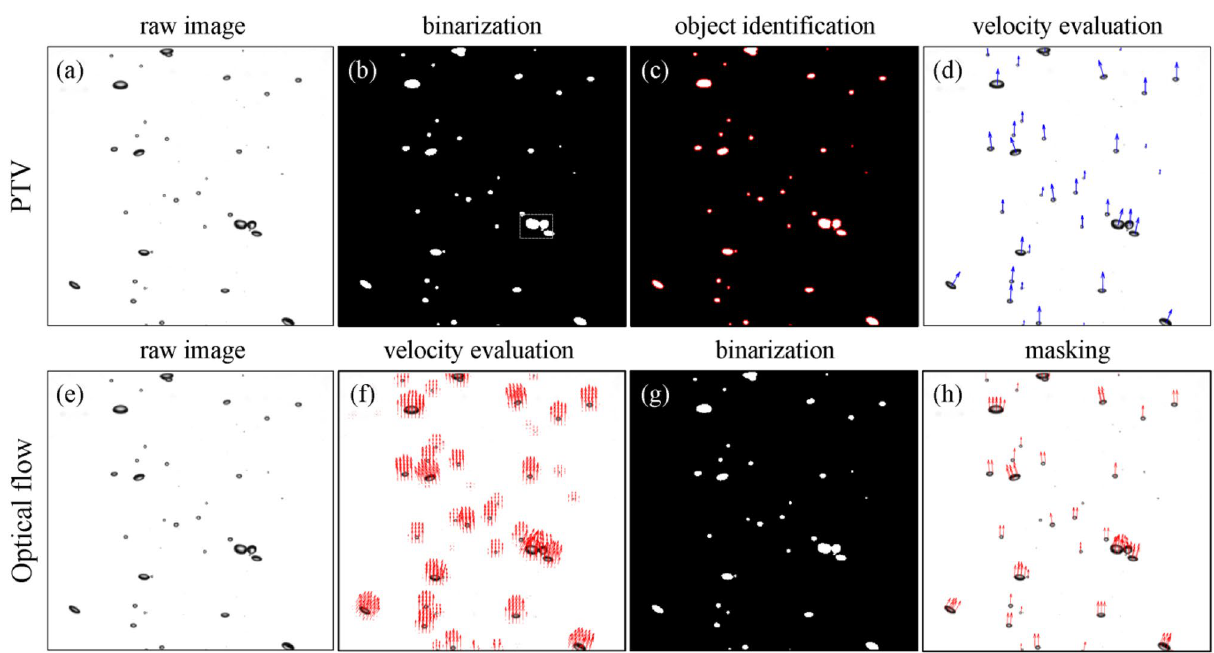
Figure 1. Typical procedure of evaluating the bubble velocities from the shadowgraph image of the bubbly flow: ( a–d ) conventional PTV and ( e–h ) optical flow (Farnebäck) method.